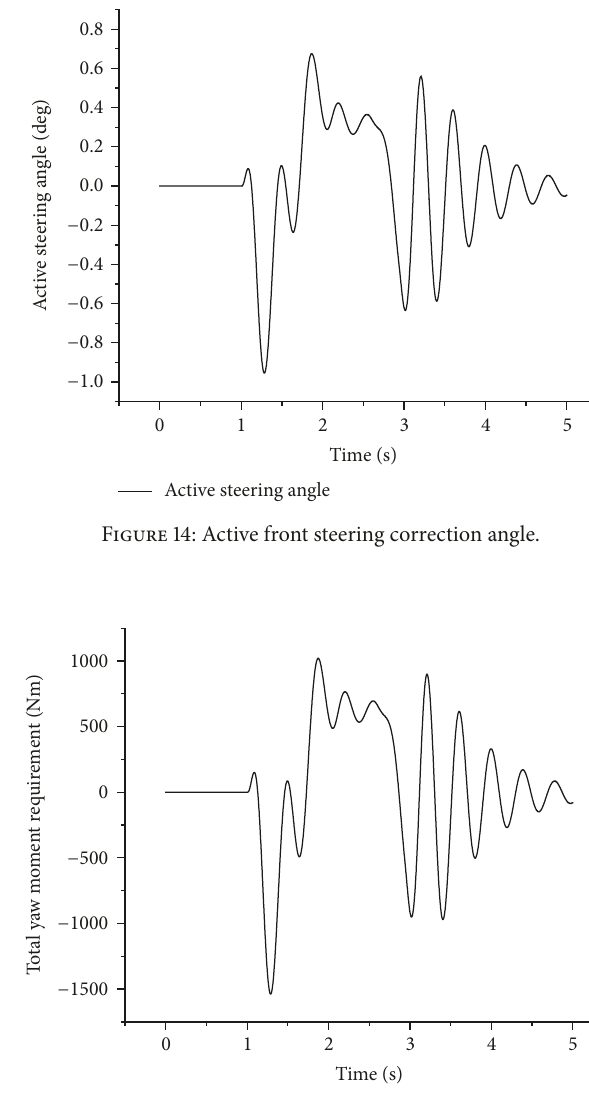
Figure 15: The total yaw moment requirement from